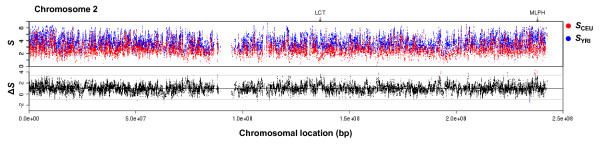
Plots for SYRI, SCEU and ΔS along chromosomal location. The entire chromosome 2 is shown. The upper panel shows entropy for both CEU (red) and YRI (blue) along the chromosomal location. The lower panel presents the entropy difference between two populations. The bold center line indicates the median of genome-wide distribution and the outer lines indicate the 0.1% tails. SNPs in the tails are shown for the CEU signature (red) and for the YRI signature (blue). Arrows indicate the LCT and MLPH gene regions.